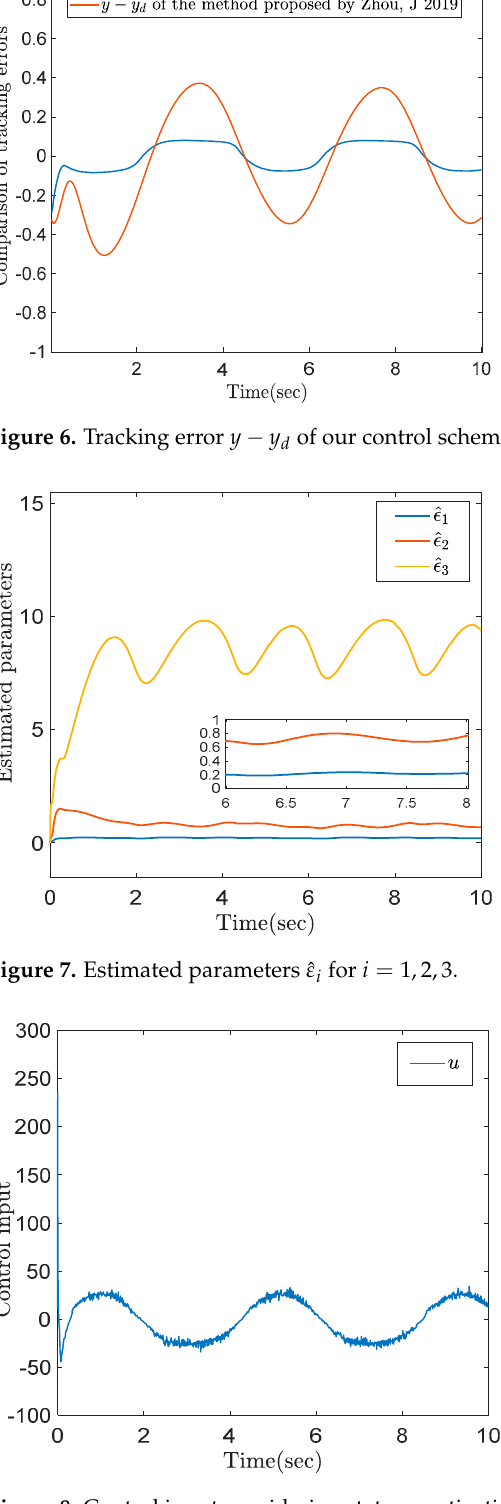
Figure 8. Control input considering state quantization.